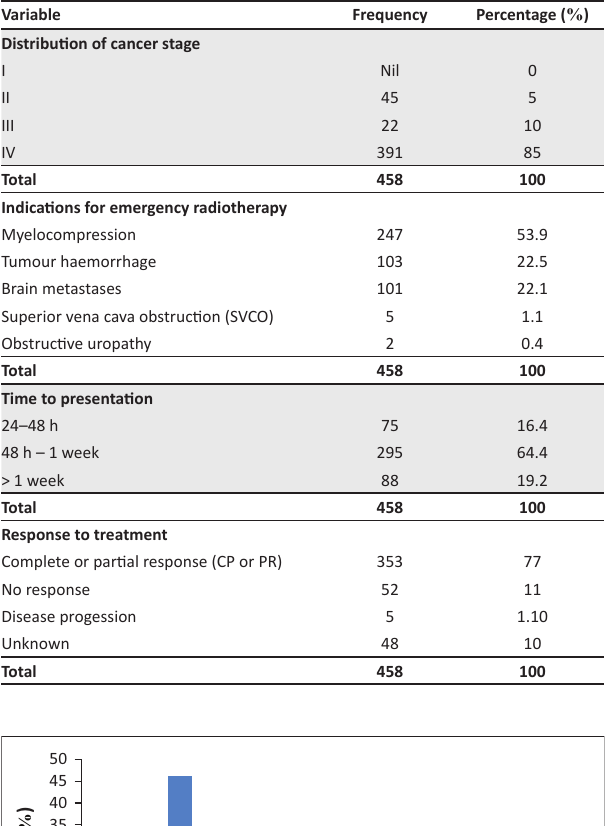
TABLE 1b: Frequency table for the stage, indications, presentation and outcome of radiation oncology emergencies. Variable